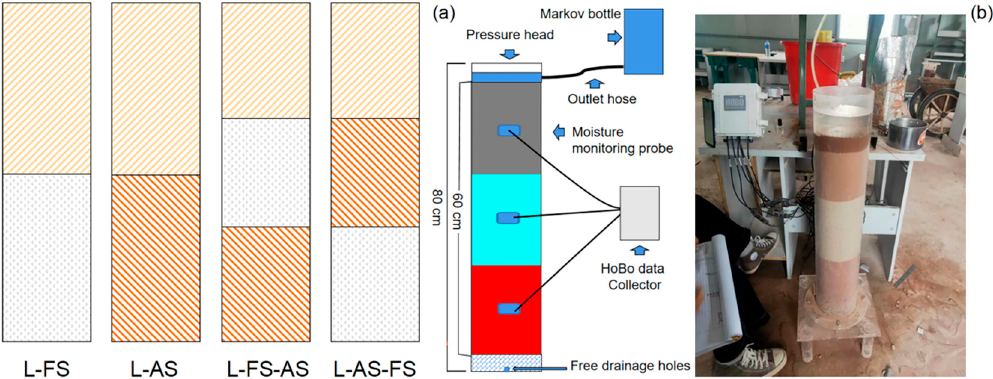
Figure 2. Schematic of the one ‐ dimensional vertical infiltration test. ( a ) Schematic of the types of soil ‐ covered sandstone required for the test. ( b ) Test device. Table 1. Basic physical properties of the filled soil samples.